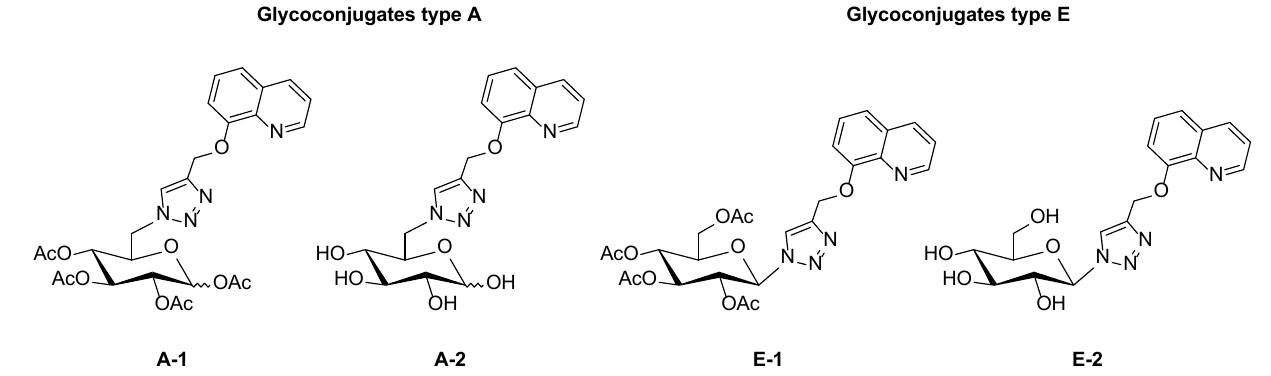
Figure 2. Structures of analogous quinoline glycoconjugates functionalized at the C-6 position ( A-1 , A-2 ) or the anomeric position ( E-1 , E-2